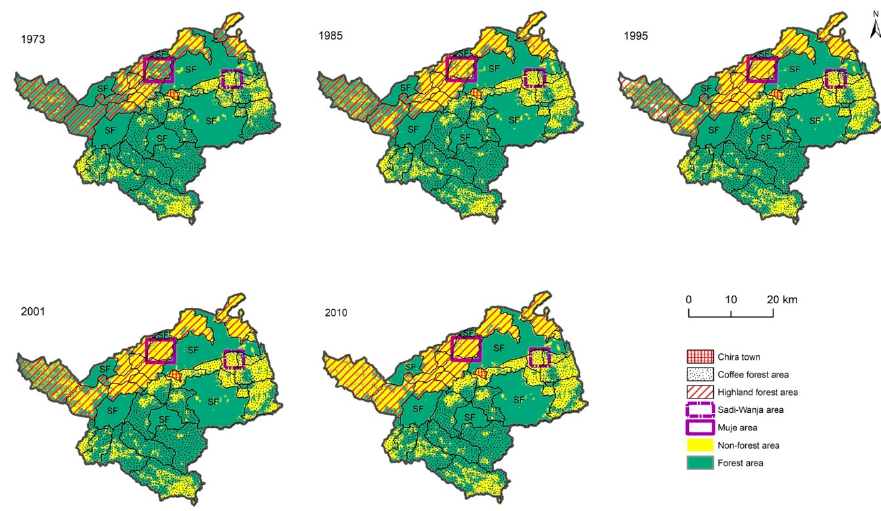
Figure 2. Forest and non-forest land cover in Gera from 1973 to 2010.